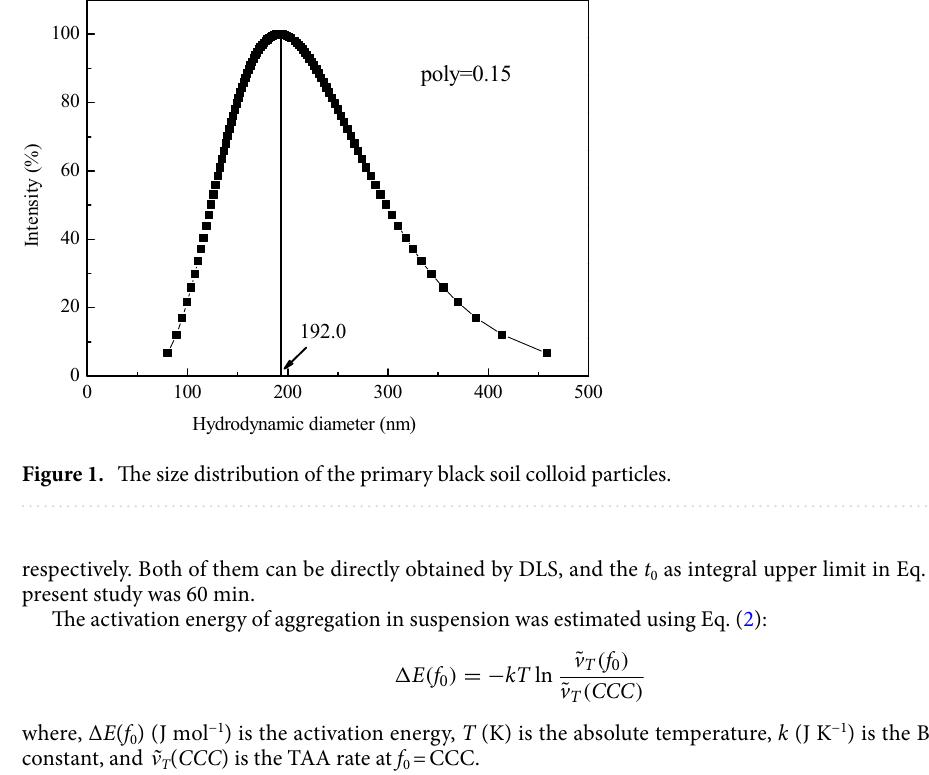
where, Δ E ( f 0 ) (J mol −1 ) is the activation energy, T (K) is the absolute temperature, k (J K −1 ) is the Boltzmann constant, and ṽ T ( CCC ) is the TAA rate at f 0 = CCC.